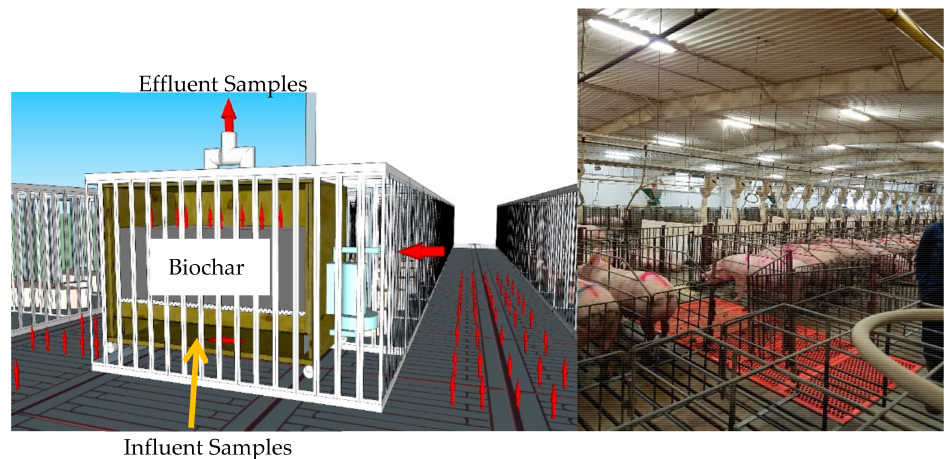
Figure 2. Pilot-scale biochar odor removal system (PSBORS) inside a swine nursery